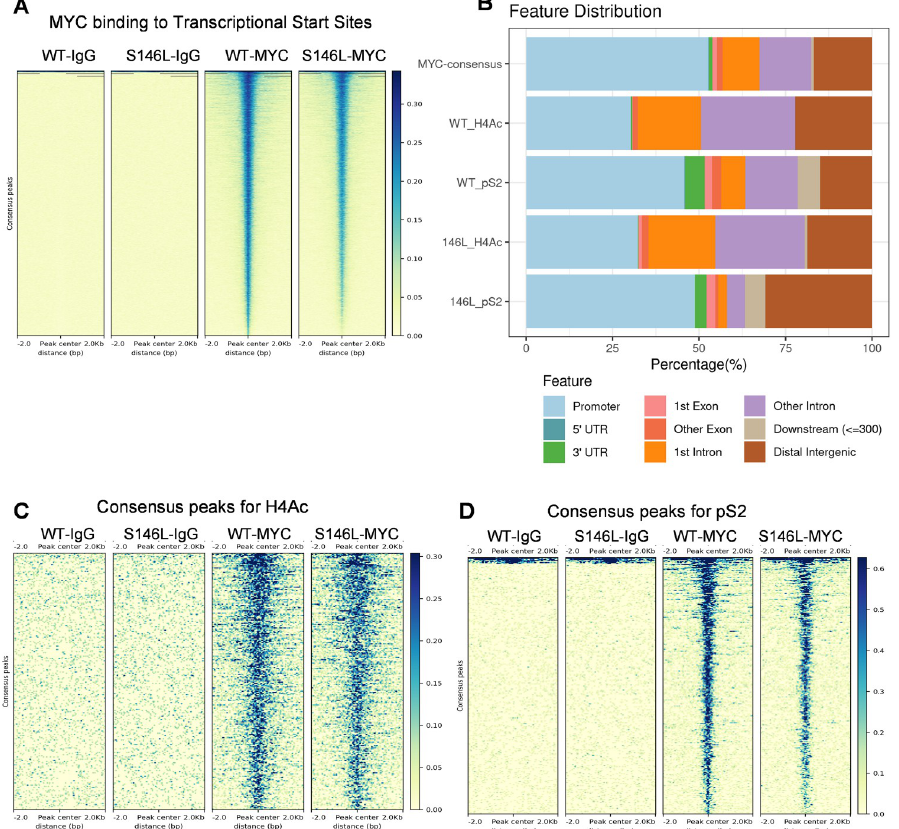
Fig 4. Chromatin localization between WT MYC and MYC S146L is not significantly different. (A) Heat map of reproducible MYC binding peaks observed in CUT&RUN in MCF10A cells expressing WT MYC or MYC S146L. (B) Feature distribution of consensus peaks between WT MYC and MYC S146L. (C) Differential binding analysis of MYC-overlapping H4Ac peaks observed in CUT&RUN in MCF10A cells expressing WT MYC or MYC S146L. (D) Differential binding analysis of MYC-overlapping pS2 peaks observed in CUT&RUN in MCF10A cells expressing WT MYC or MYC